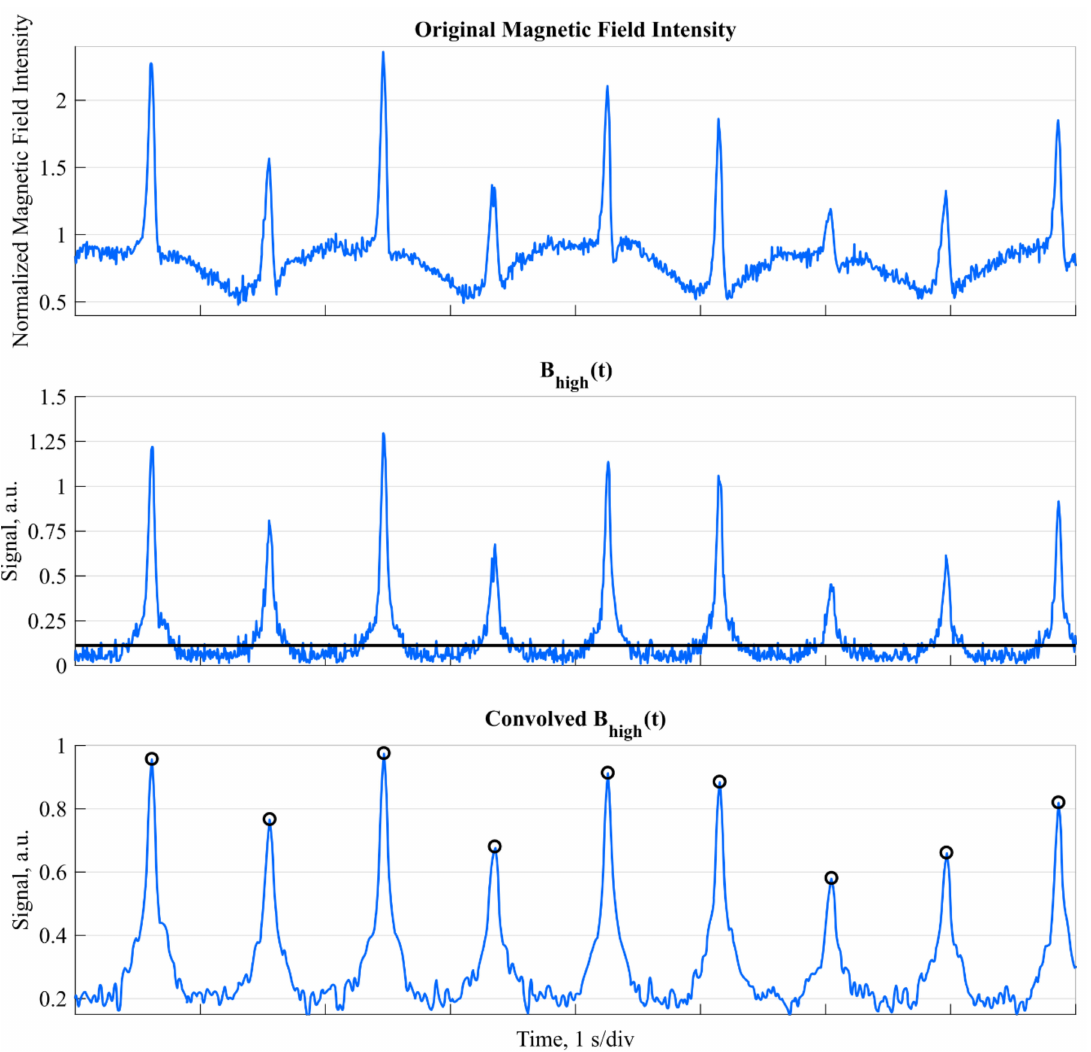
Figure 3. Original magnetic field intensity (top), high-pas filtered field intensity B high ( t )